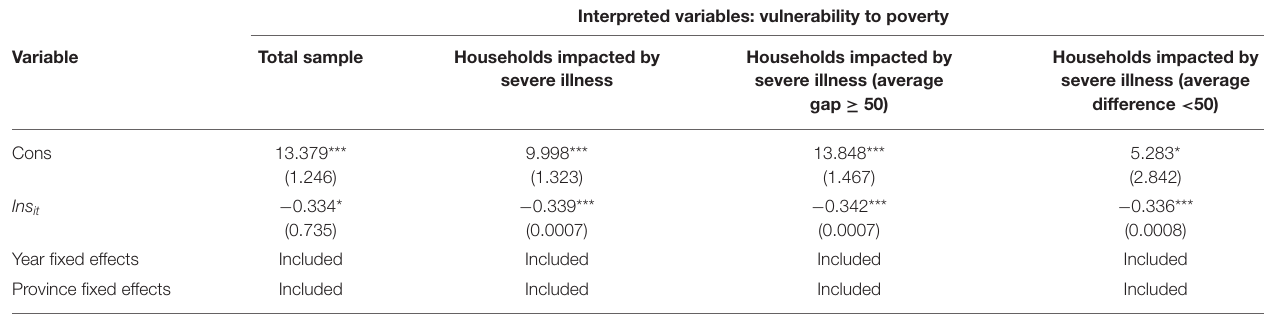
TABLE 3 | Fixed utility model test results of the impacts of major illness insurance on poverty vulnerability.